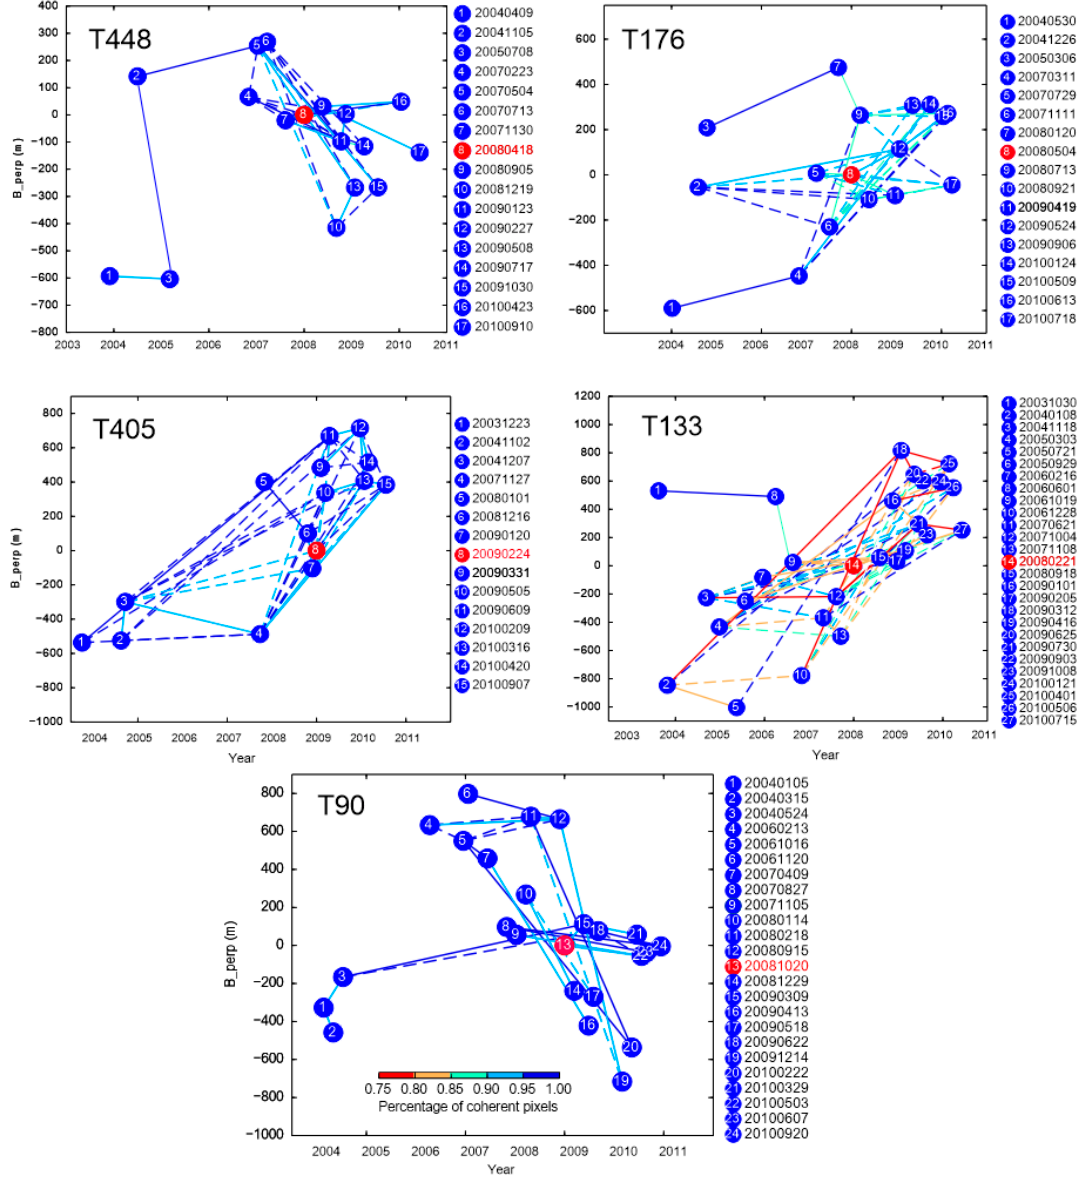
Figure 2. Perpendicular and temporal baseline plot showing the network of interferograms on five descending tracks 448, 176, 405, 133 and 90 used in this study. The dates listed on the right of each subplot are SAR acquisitions corresponding to the labelled blue circles, the red circles mark the master images for each track. The lines present the interferometric pairs coloured according to the fraction of successfully unwrapped pixels normalized to the interferogram with the best coherence on each track. The solid lines are selected interferograms derived by the minimum spanning tree algorithm (MST) [38].